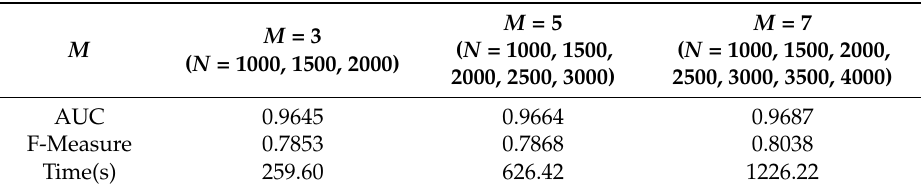
Table 6. Comparison results of different M.